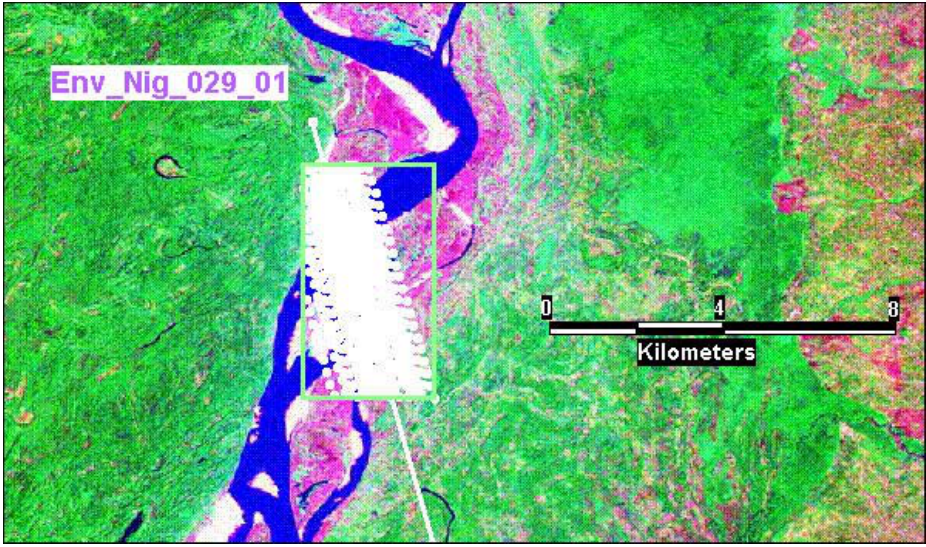
Figure 2. Illustration of a virtual station, where altimetry satellite tracks intersect the river Niger.